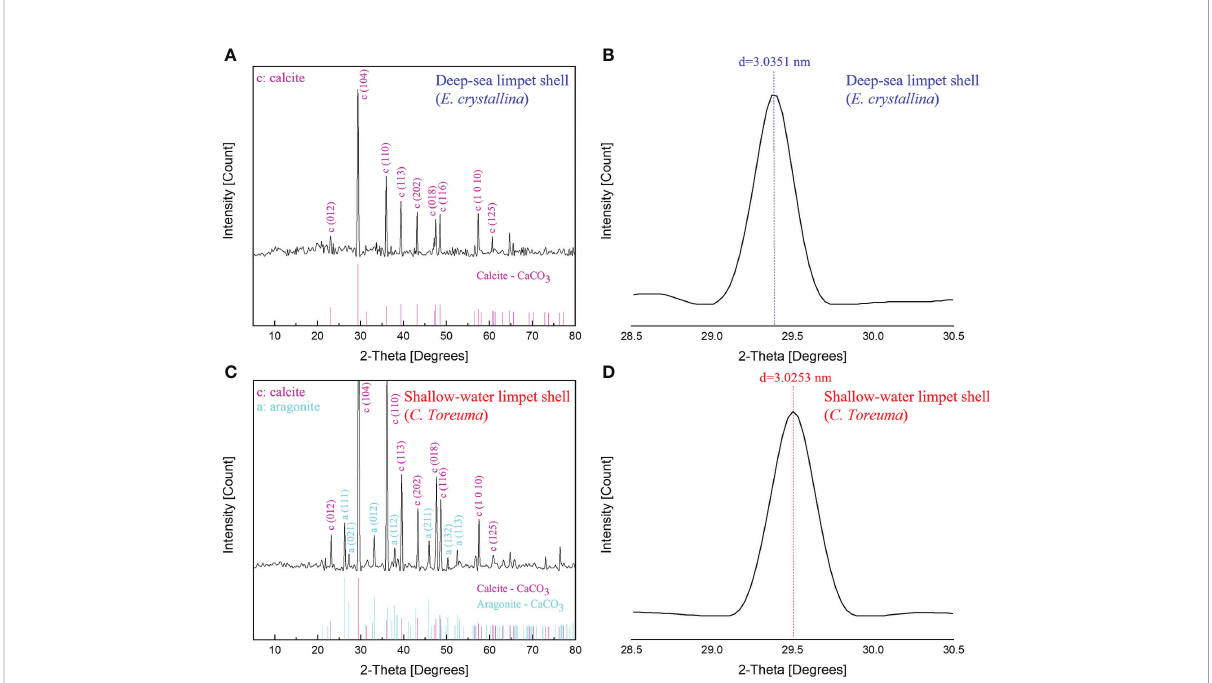
FIGURE 8 The XRD spectra of (A) deep-sea limpet E. crystallina shells containing pure calcite-CaCO 3 . (B) The detailed diffraction peak information of deep-sea limpet E. crystallina shells which is consistent with the literature value. (C) Shallow-water limpet C. toreuma shells containing two types of CaCO 3 polymorphs, i.e., calcite and aragonite. (D) The detailed diffraction peak information of shallow-water limpet C. toreuma shells deviated from the literature